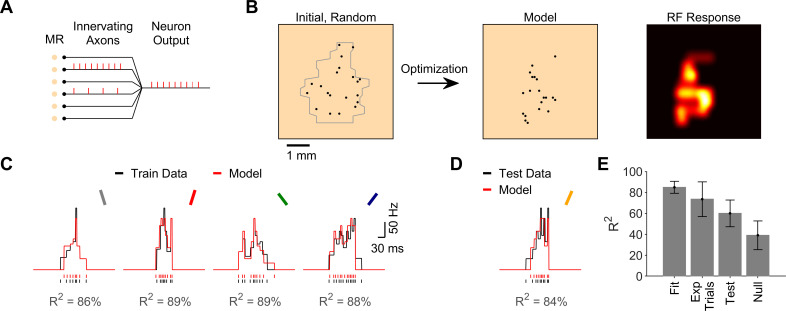
Data-driven models of first-order tactile neurons.A. The model neuron innervated a set of mechanoreceptors (MRs), each with its own axonal branch and spiking zone. The model neuron output followed a “reset” scheme, whereby spikes triggered at one axonal spiking zone reset initiation at other spiking zones. B. The locations of innervated mechanoreceptors (black) were derived by the model optimization algorithm. At the start of the optimization, locations were random within the area derived from the recorded neuron’s response to a moving dot stimulus (gray, see Methods). The resulting model innervation pattern and receptive field (RF) response map are shown for the example FA-1 neuron whose response is illustrated in parts C and D. C. Fitness (R2) of a model for an example FA-1 neuron. Observed (black) and model (red) spike trains and rate curves in response to edges oriented -22.5, 22.5, -45, and 45°. D. Observed and model response to an edge oriented 30°, which served to test the models. E. Model fitness, R2 between different trials of the recorded neuron’s response to the test orientation (30°), model prediction accuracy for the test orientation (30°), and the prediction accuracy of null models (shuffled, see Methods) across all neurons (n = 15). Prediction accuracy of the models was significantly higher than that of null models (p < 10−4, paired-sample t-test). Error bars depict standard deviation.